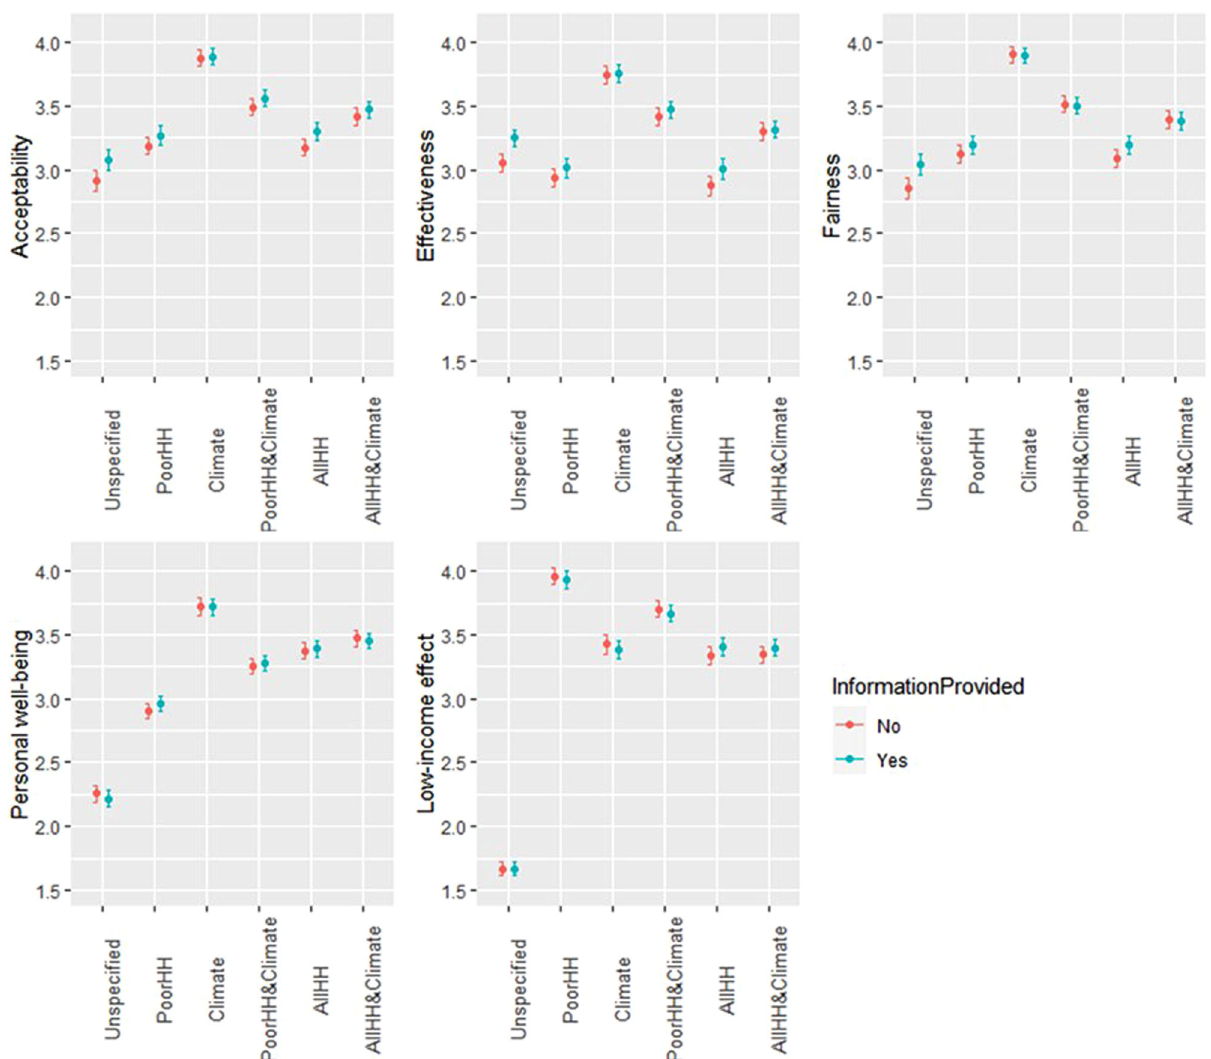
Fig. 4 Effect of providing information on acceptability and perceptions under distinct revenue uses. Dots indicate the average results with error bars indicating + / − 2 s.e. All survey questions were using a 5-point scale (e.g. acceptability: 1 = completely unacceptable to 5 = completely acceptable). N = 2004 (1000 with no information provided and 1004 with information provided) for each revenue use option and for acceptability and each of the four